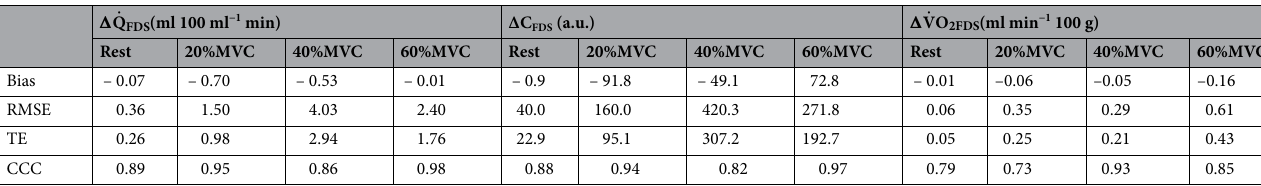
Table 2. Measurement agreement for muscle blood flow and O 2 uptake between the venous, arterial and ˙ Q and (cid:31) C : differences in muscle blood flow combined occlusions. FDS: flexor digitorum superficialis muscle; (cid:31) and vascular conductance between venous (VO) and combined (COMBO) occlusion trials, respectively (i.e., ˙ VO 2 : difference in muscle O COMBO–VO); (cid:31) 2 uptake between arterial occlusion (AO) and COMBO trials (i.e., COMBO–AO); MVC: maximal voluntary contraction; RMSE: root mean squared error of the differences; TE: typical error; CCC: concordance correlation coefficient.